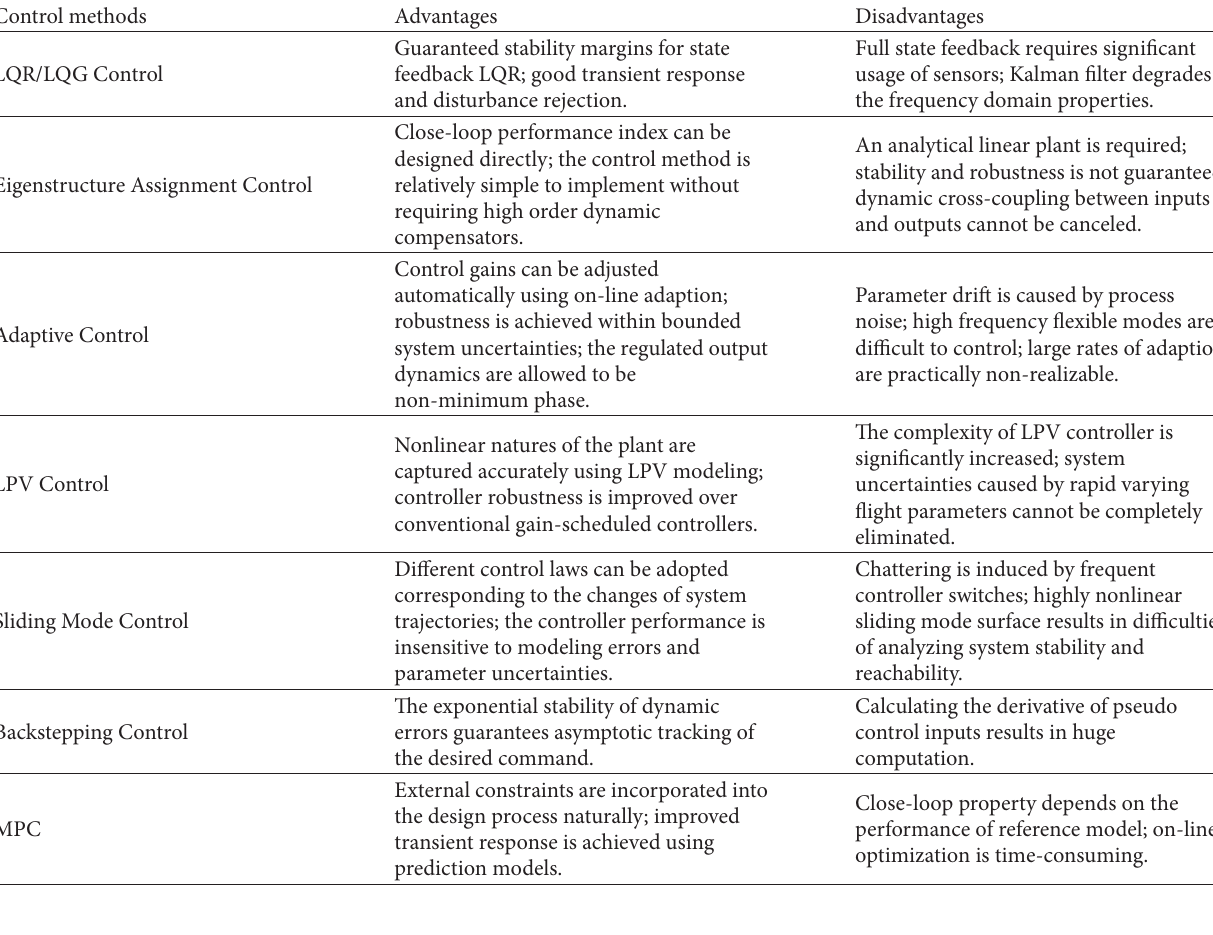
Table 1: Summary on modern control methodologies.